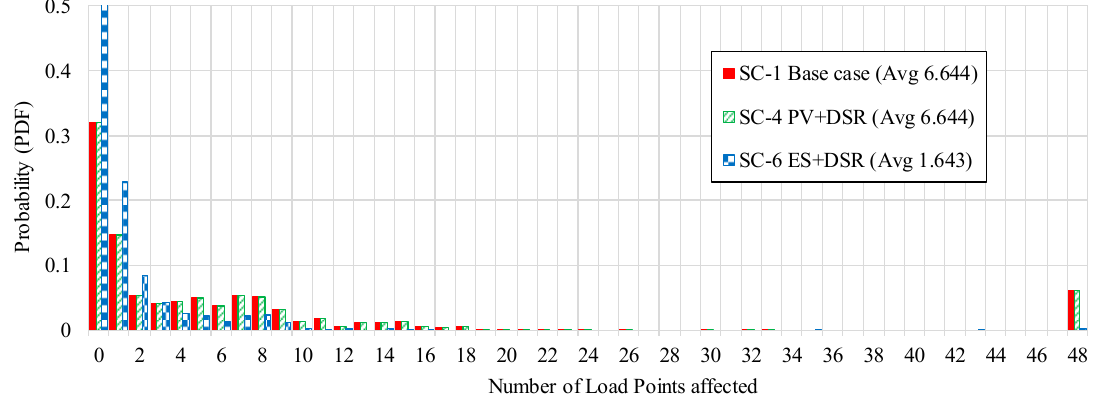
Figure 11. Probabilities of the number of load points affected by supply interruptions.